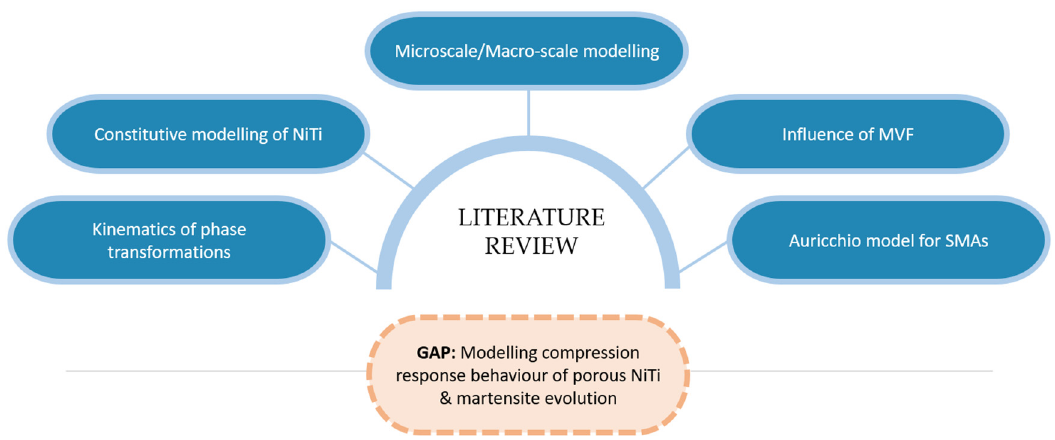
Figure 5. Schematic of the literature review content. Based on the gap in the literature in compressive response modelling of NiTi SMA, the scope of the current original work presented in this paper on the macroscale and microscale modelling of NiTi.